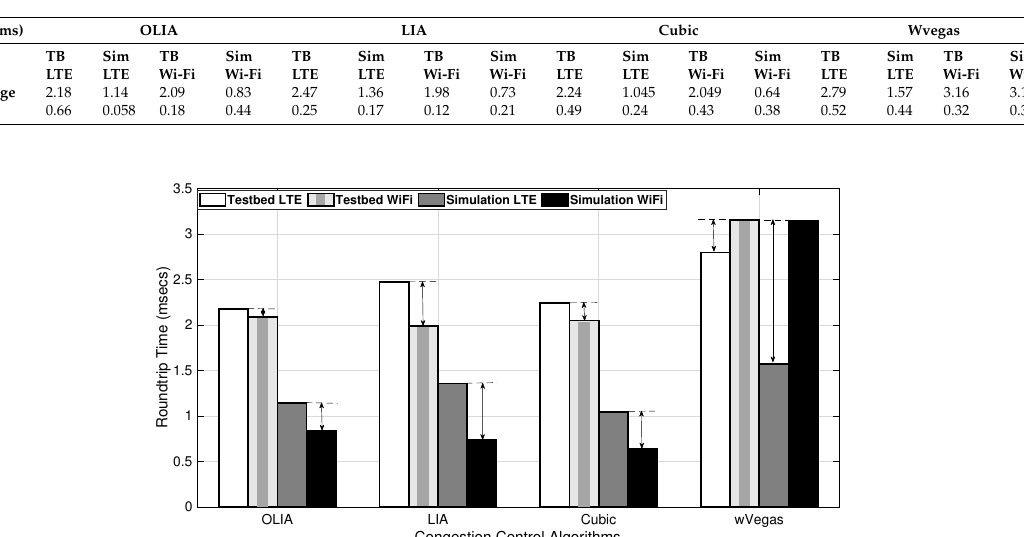
Table 3. Setup 1 uplink RTT for 20 MB flows.